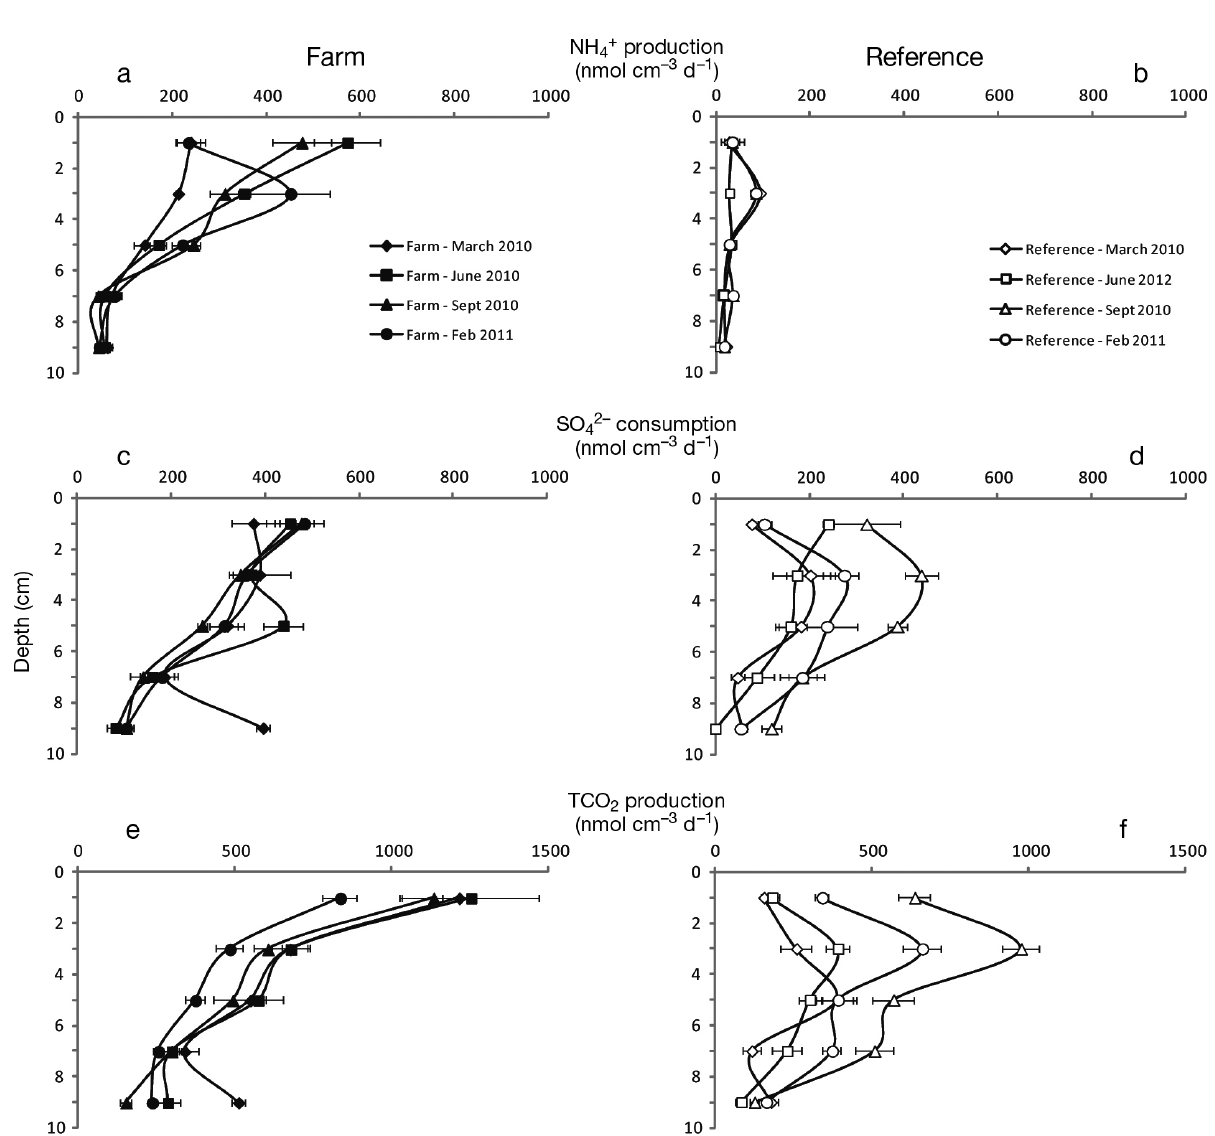
Fig. 6. Spatial distribution of microbial reaction rates based on jar experiments at the farming (solid symbols; upper panels) and reference (open symbols; lower panels) locations in March, June and September 2010: (a,b) total CO 2 (TCO 2 ) production, (c,d) SO 42− consumption and (d,e) NH 4+ production. Error bars represent SE of the slope of linear regressions (metabolite concentration vs. time) corrected for sediment